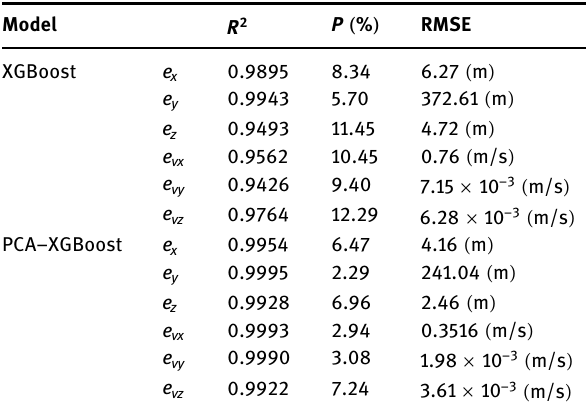
Table 6: Results of XGBoost model and PCA – XGBoost model for the training dataset